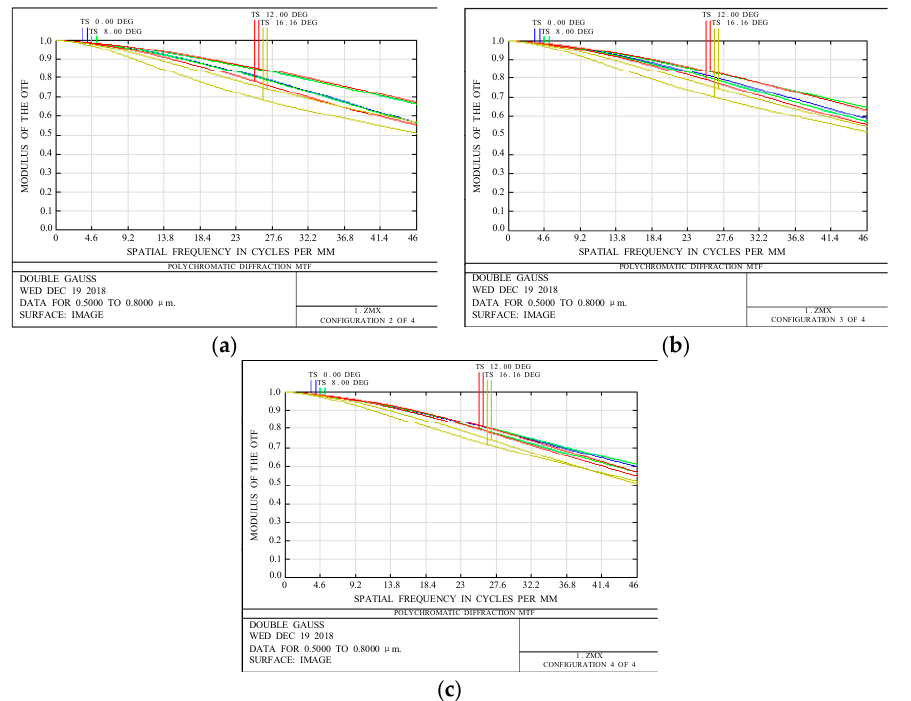
Figure 10. Graphs of modulation transfer function. ( a ) − 20 °C ; ( b ) 20 °C ; ( c ) 60 °C .